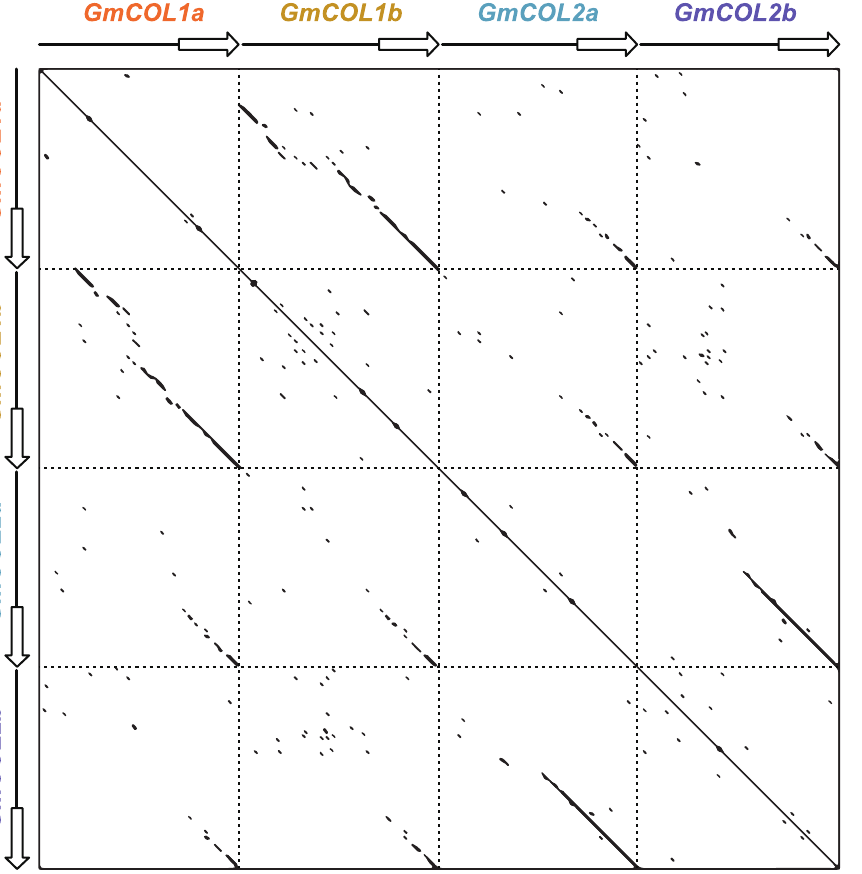
Figure 6. Comparison of the 2.5 kb upstream intergenic region and the coding region of GmCOL1a , GmCOL1b , GmCOL2a and GmCOL2b . Empty arrows indicate the coding sequence (introns were excluded); lines indicate the upstream intergenic region. Conserved sequences between two sequences are evident from the detected diagonal dotted lines. The dot plot was created using the Nucleic Acid Dot Plots program, with the following parameters: window size: 11; mismatch limit: 0.